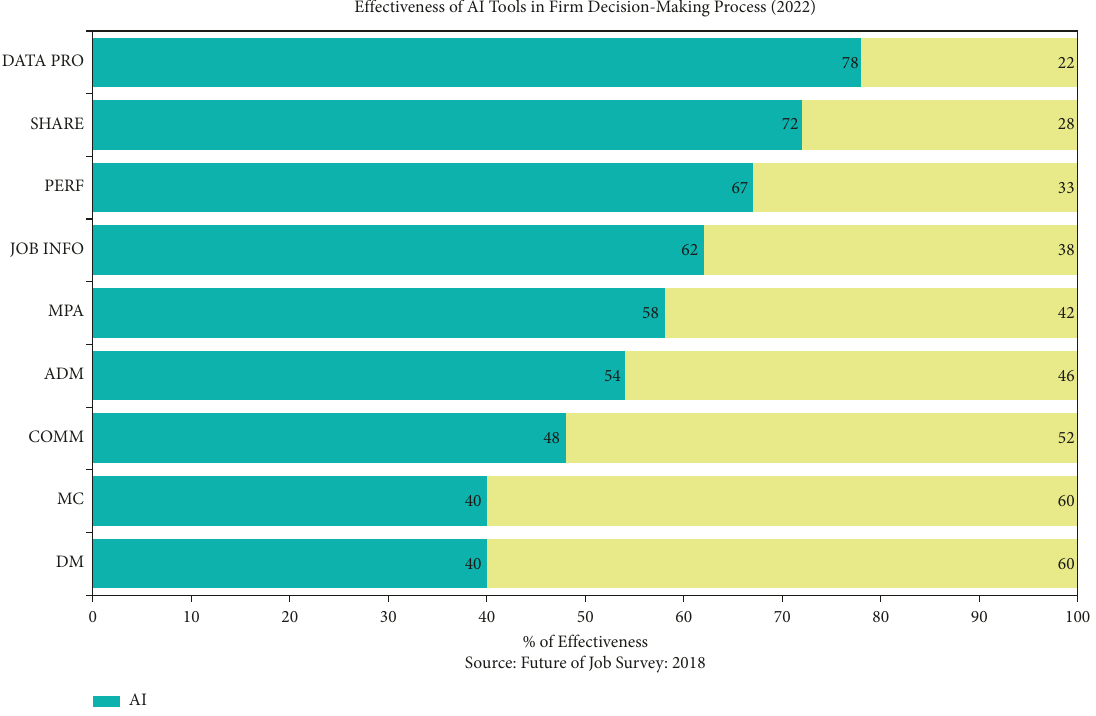
Figure 11: Effectiveness of AI tools in firm decision-making process